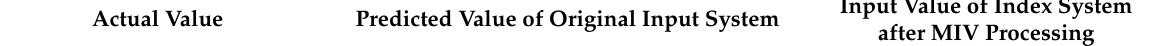
Table 10. Calculation results of the test